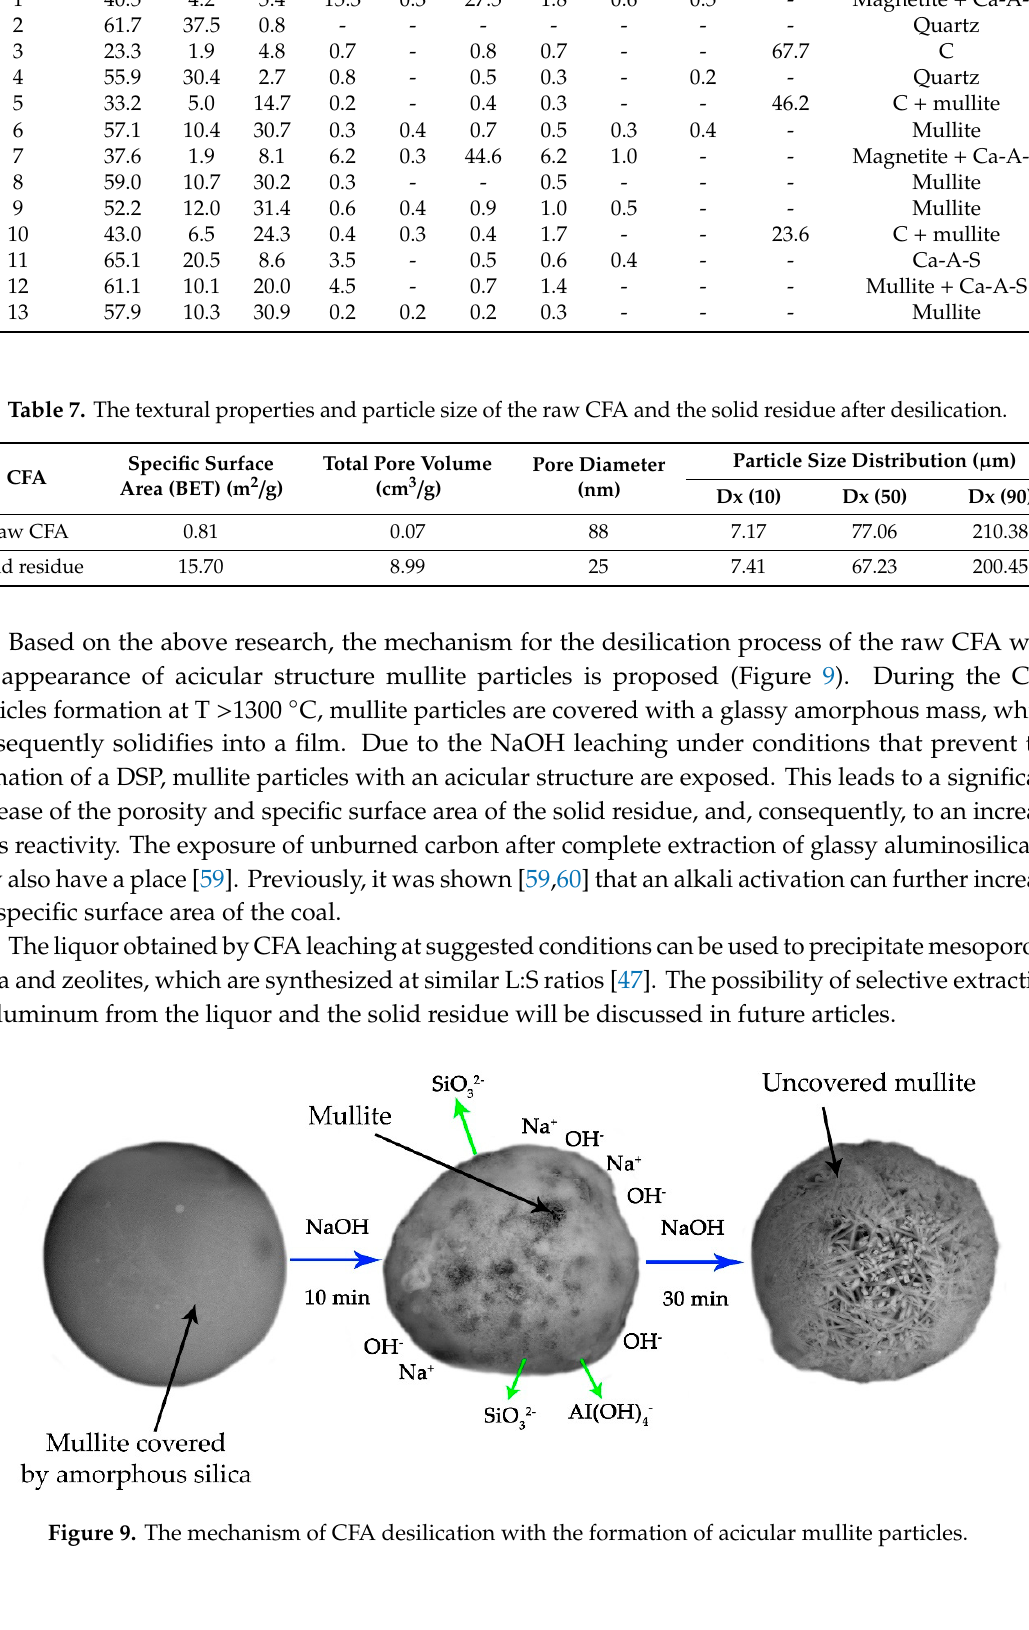
Table 6. The elemental compositions (wt.%) of solid residue (see Figure 8 for the spectra numbers). Spectrum